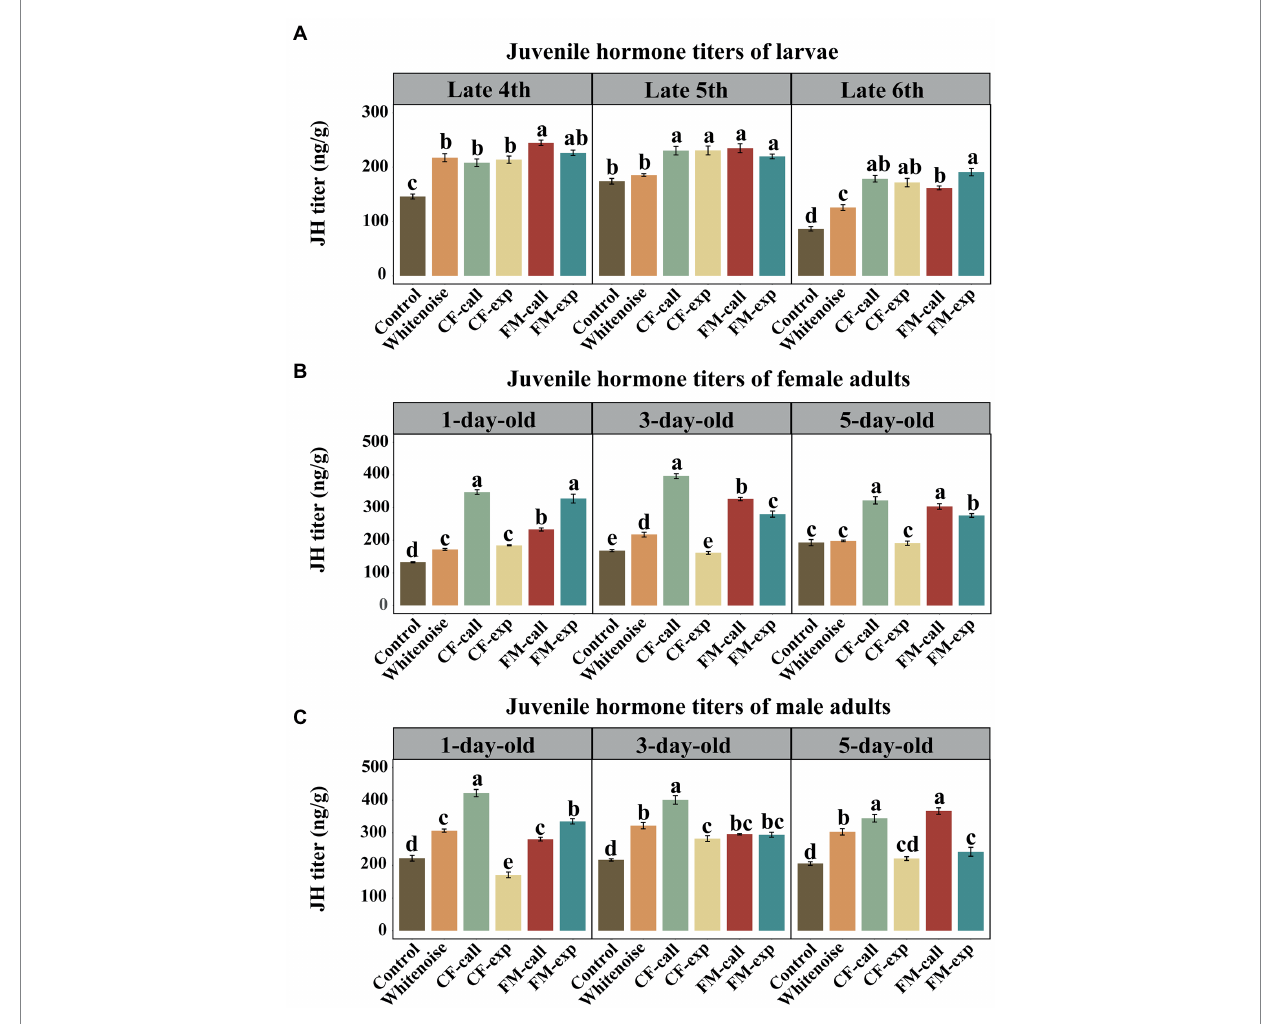
FIGURE 3 The JH titers of S. litura under different types of predation risk. The JH titers of (A) larvae of different ages, (B) female adult moths, and (C) male adult moths. The data are expressed as the mean ± SD. Different letters on the bars indicate significant differences between treatments (Tukey’s test, p <